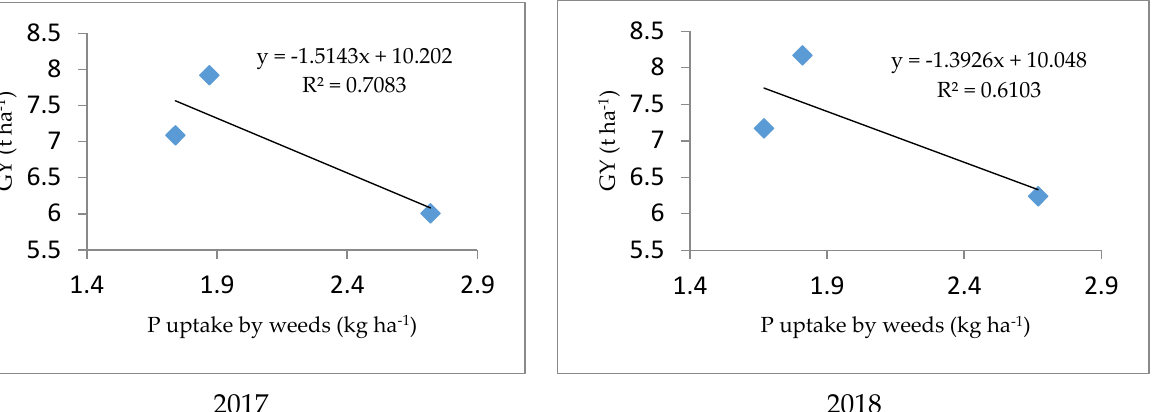
Figure 10. Linear regression line among crop establishment methods between N uptake by weeds vs. Grain yield (GY).